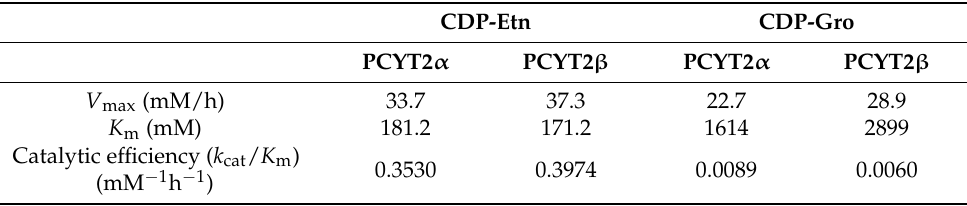
Figure 3. Characterization of enzymatic activities of PCYT2. ( A ) HPLC profiles of the reaction mix- tures in the presence and absence of the candidate enzymes listed in Table 1 and positive (TagD) and negative controls. The peak corresponding to CDP-Gro is indicated with the arrow. ( B ) The enzymatic activities of PCYT2 α and PCYT2 β with various glycerol-3-phosphate or ethanolamine phosphate and CTP concentrations are plotted. CDP-Gro/CDP-Etn synthase activities of PCYT2 α ( (cid:72) / • ) and PCYT2 β (Ø (cid:7) / (cid:78) ) are represented, respectively. The data were fitted to the Michaelis–Menten equation by nonlinear regression (GraphPad Prism 9; https://www.graphpad.com/scientific-software/prism/). The apparent Michaelis constant ( K m ) and the maximal velocity ( V max ) were calculated. Table 2. The enzymatic parameters of CDP-Gro or CDP-Etn synthase activities of PCYT2 isoforms using glycerol-3-phosphate or ethanolamine phosphate as substrates,